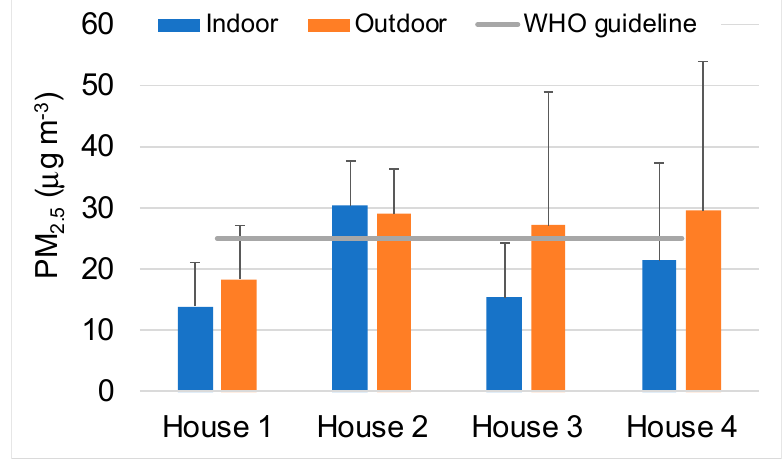
Figure 1. PM 2.5 concentrations monitored in kitchens and outdoor air.